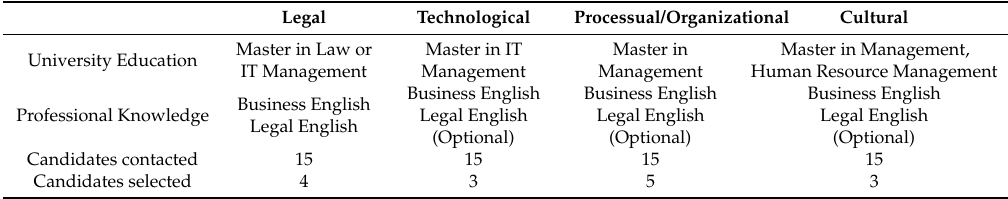
Table 2. Item validation selection criteria, candidates, and final set of